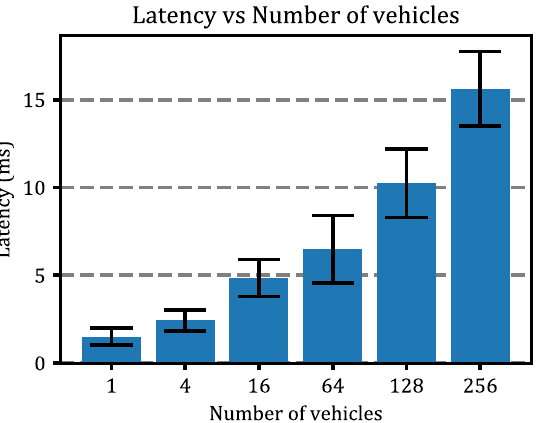
Figure 7. Latency vs. Number of vehicles. It represents the mean and standard deviation values each group. for each group. Table 3. Results of latency simulation.